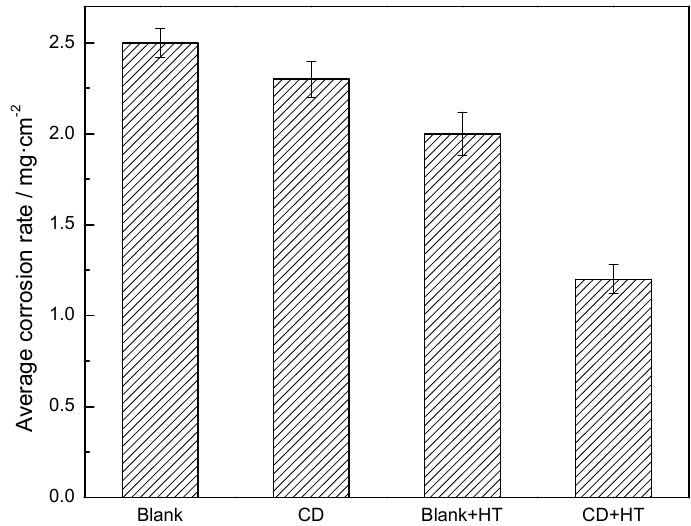
Figure 4. Average corrosion rate of Mg alloy samples in 3.5 wt % NaCl solution with pH 7.0 at 37 °C for 48 h.